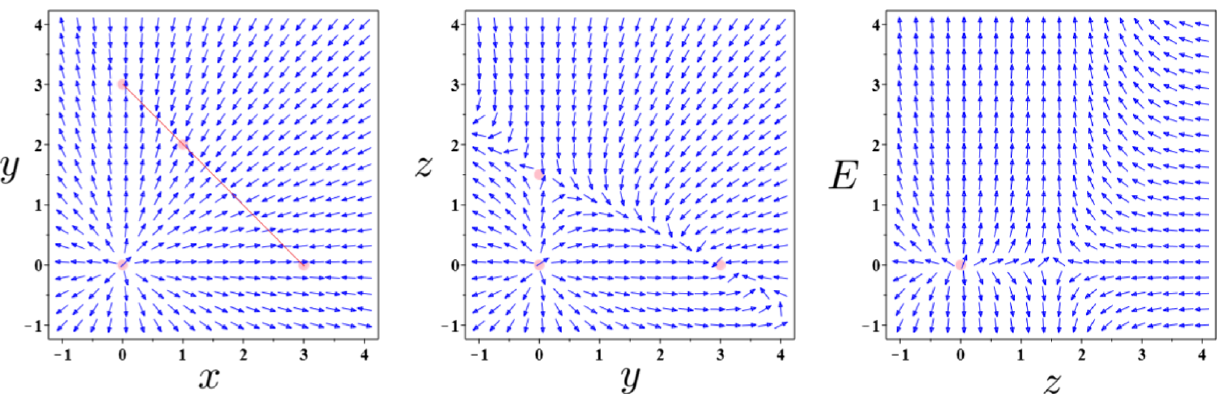
Fig. 9 This figure indicates three different phase-portraits of the sys- tem (228)–(231) when one sets j = 0, w 0 = 0, ζ 0 = − 6, α = − 4, q = 18, κ 2 = 1, and w 1 = − 18. The pink points represent the critical pointsandthethinredline(from ( x , y ) = ( 0 , 3 ) to ( x , y ) = ( 3 , 0 ) )indi-